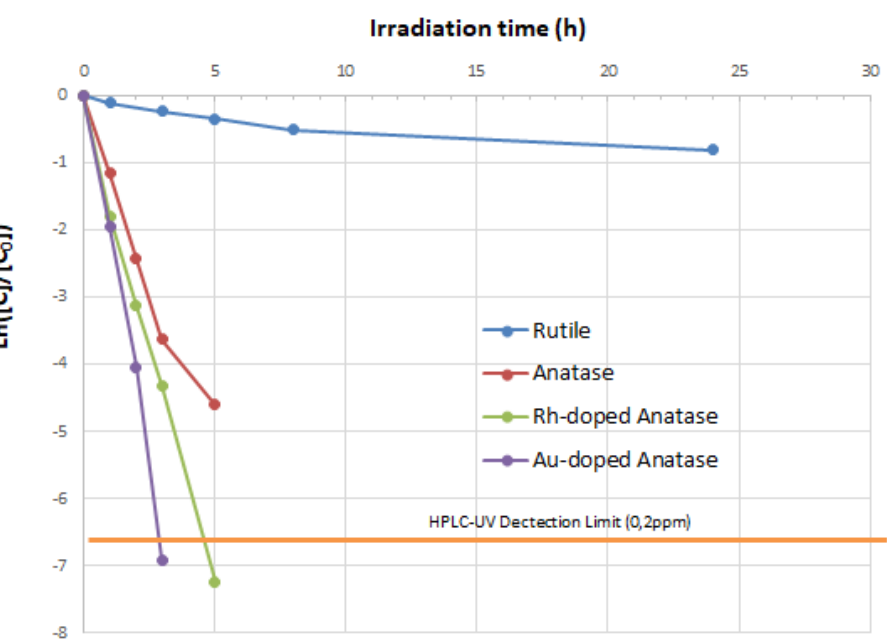
Figure 5. Kinetic photodegradation of aqueous diethyl phthalate solution with different catalysts (TiO 2 anatase or rutile polymorphs, Rh(0)NPs@TiO 2 and Au(0)NPs@TiO 2 ). The reaction conditions were as follows: T = 20°C, C 0 = 222 mg·L −1 , unregulated pH and an incident light flux of 16 W·m −2 .